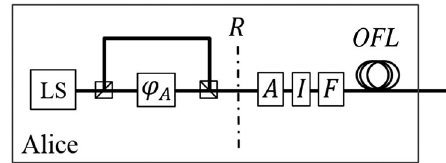
FIG. 5. Architecture of a QKD transmitter to mitigate the THA. LS is a generic light source and the square with φ A is the encoding device. OFL: optical fiber loop determining the LIDT; F : optical filter; I : optical isolator; A : attenuator; R : total reflection from all components to the left of the dot-dashed